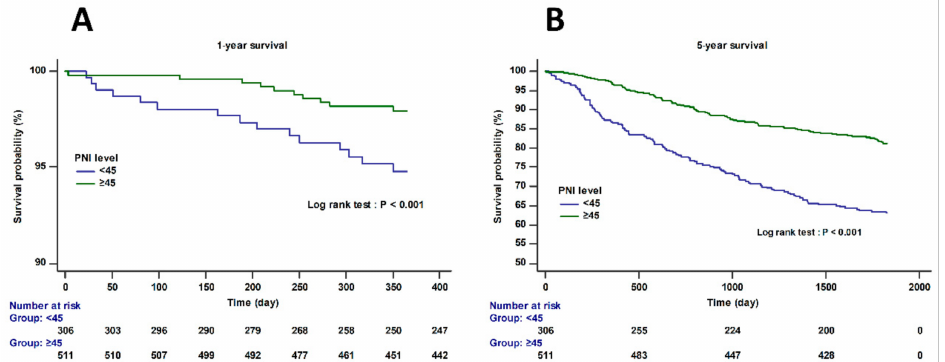
Figure 2. Kaplan–Meier curves for one-year ( A ) and five-year survival ( B ) according to the preop- erative PNI cutoff value < 45 (log-rank test; p < 0.001). The proportional hazards assumption was satisfied in Schoenfeld’s residual test ( p =